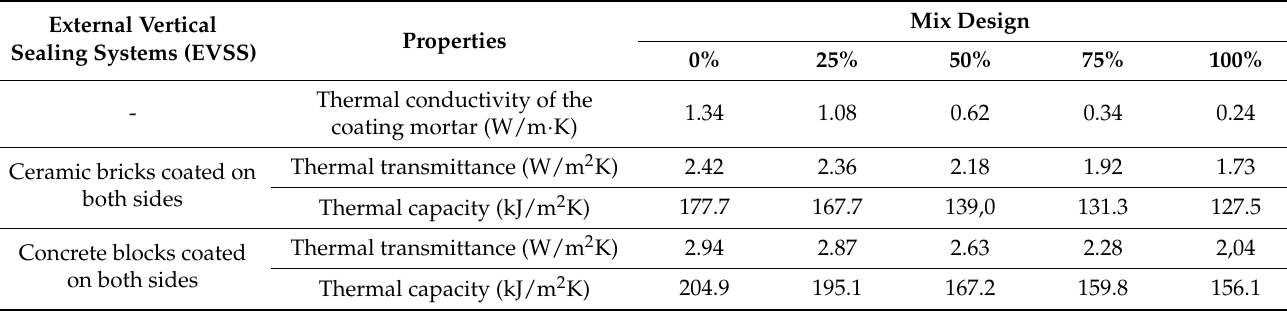
Table 13. Thermal mortar performance in EVSS